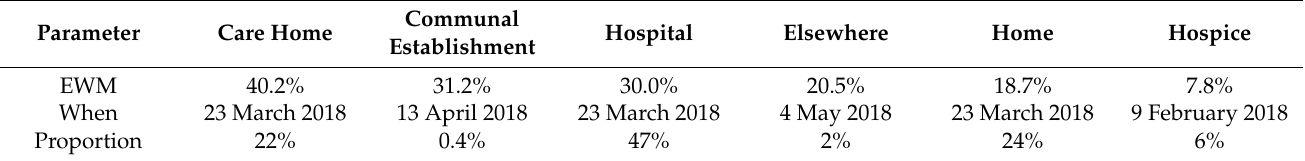
Table 7. Effect of place of death on EWM for the winter of 2017/18 in England and Wales, weekly data. Parameter Care